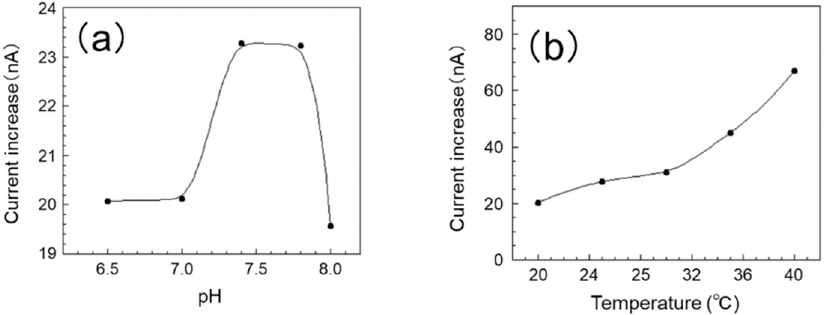
Figure 3. Effects of assay conditions on the sensor response. ( a ) pH (glucose concentration 200 mg dL − 1 , 30 °C); ( b ) Temperature (glucose concentration 200 mg dL − 1 , pH 7.8).